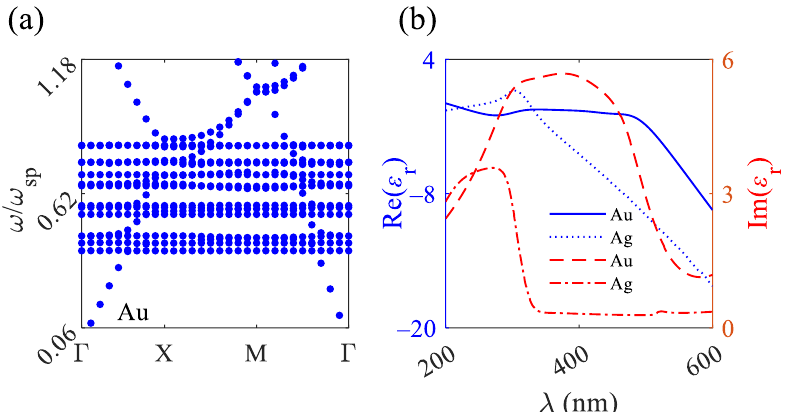
Figure 2. ( a ) Band structure of 2D MPHCs consists of Au rods in air under TE polarized light. ( b ) The real and imaginary parts of permittivity for Au and Ag over a wavelength range of 200–600